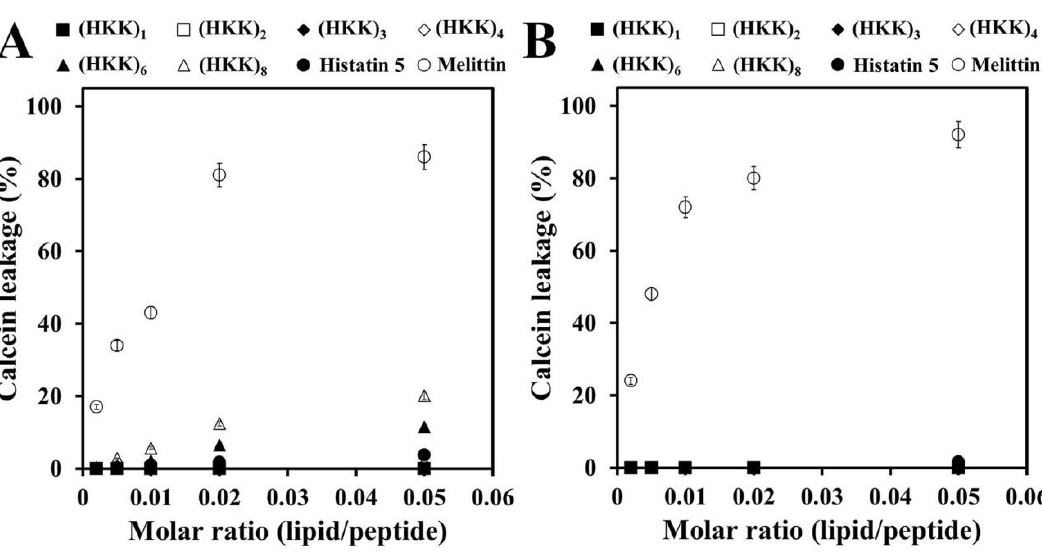
Figure 2. Cellular distribution and membrane-permeable effects of peptides in C. albicans cells. ( A ) After 1 h of incubation of C. albicans cells with FNR675-labeled (HKK) 2 (a), (HKK) 4 (b), (HKK) 6 (c), and (HKK) 8 (d) peptides, the washed cells were observed under confocal laser-scanning microscopy (CLSM). ( B ) SYTOX Green-pretreated C. albicans cells in the presence of peptides were measured using flow cytometry.